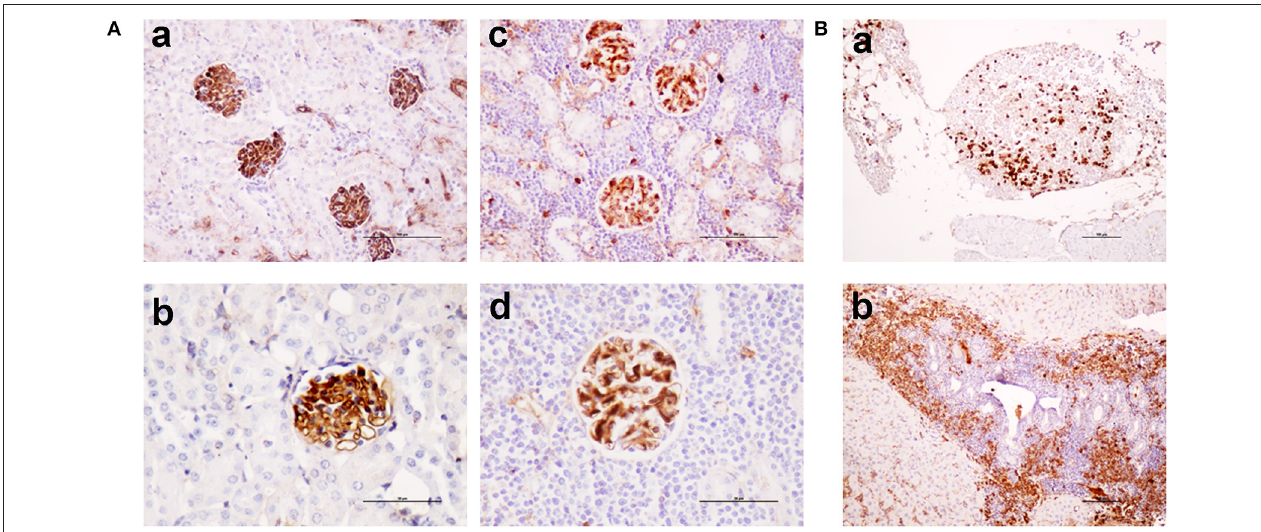
FIGURE 6 | TRAF3/BCL2 double-tg mice develop autoimmune features similar to the TRAF3 -tg mice. (A) IgG depositions in glomeruli of TRAF3/BCL2 double-tg mice in samples showing an otherwise normal kidney architecture [ (a) , 100 x and (b) , 200 x] or showing heavy lymphocyte infiltration [ (c) , 100 x and (d) , 200 x]. Microphotographs are from 4 representative TRAF3/BCL2 double-tg mice. Staining was performed with anti-mouse IgG-HRP. Scale bars are shown [ (a,c) , 100 µ m; (b,d) , 50 µ m] (B) . Tertiary lymphoid organs formation in the TRAF3/BCL2 double-tg mice. Two representative examples of tertiary lymphoid organs developed in two mice are shown. Panel (a) shows a tertiary lymphoid organ in the omentum. Plasma cells are shown by staining with anti-mouse IgG-HRP. Panel (b) shows lymphoid neogenesis in the liver, with a prominent presence of plasma cells. Staining was performed with anti-mouse IgG-HRP. Magnification was 100 x. Scale bars are shown (100 µ